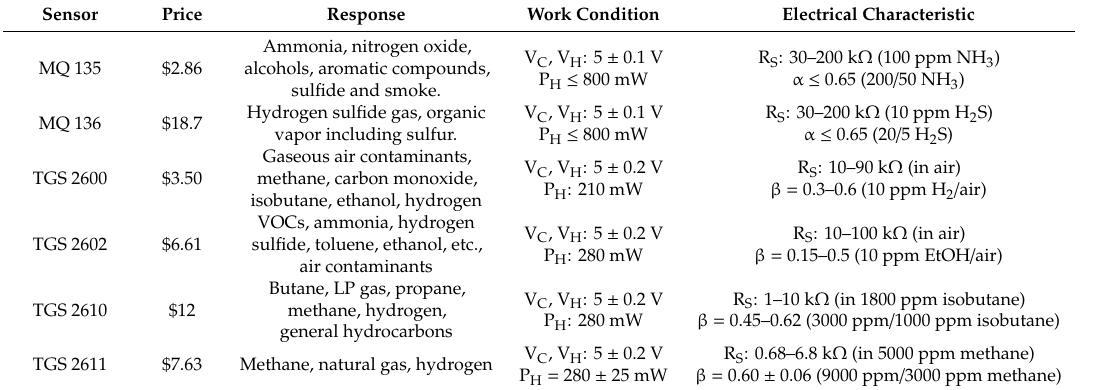
Table 1. Gas sensors in the